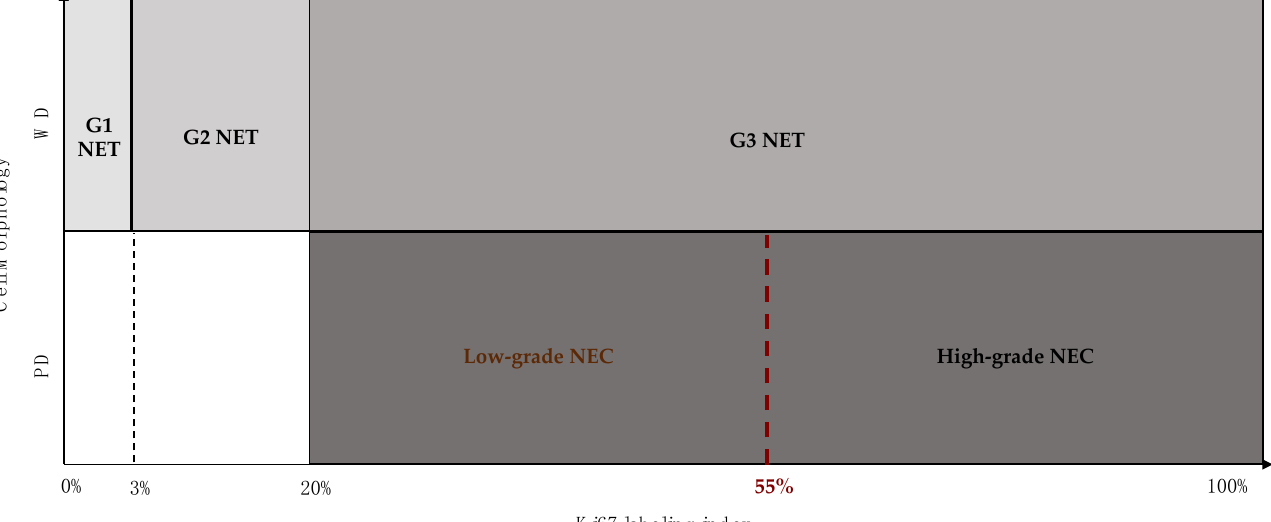
Figure 1. Current World Health Organization (WHO) gastroenteropancreatic neuroendocrine neoplasms (GEP-NENs) classification based on both cell morphology and Ki67 labelling index (LI). G1 neuroendocrine tumor (NET): a well-differentiated (WD) tumor characterized by a mitotic count <2/10 high power fields (HPFs) and/or a Ki67 LI <3%; G2 NET: a WD tumor characterized by a mitotic count 2–20/10 HPFs and/or a Ki67 LI 3–20%; G3 NET: a WD tumor characterized by a mitotic count >20/10 HPFs and/or a Ki67 LI >20%; G3 neuroendocrine carcinoma (NEC): a poorly-differentiated (PD) tumor characterized by a mitotic count >20/10 HPFs and/or a Ki67 LI >20%. As recent literature data suggested, NECs could be further subdivided into two distinct prognostic categories based on the Ki67 LI cut-off of 55%.